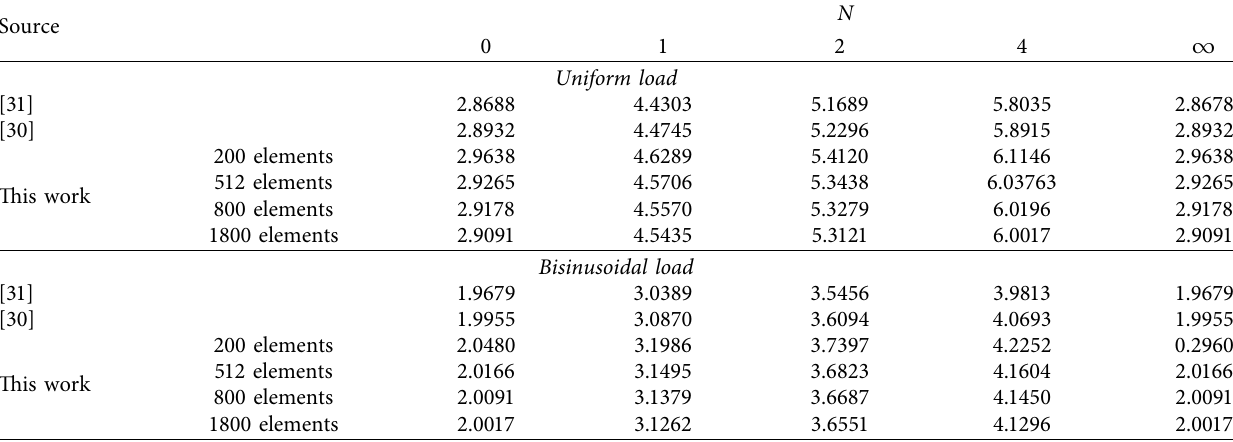
Table 2: Nondimensional stress 􏽢 σ load and sinusoidal distributed